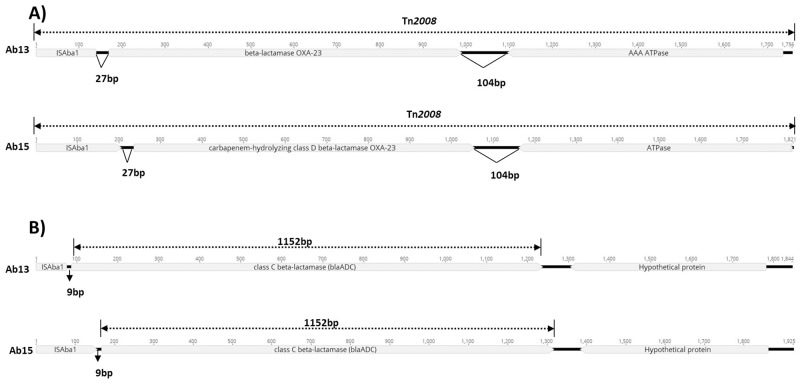
(A) Schematic representation of Tn2008 with ISAba1 located upstream of the blaOXA-23 gene in the analyzed strains. (B) Schematic representation of the ISAba1 localization upstream to the blaADC-25 gene.